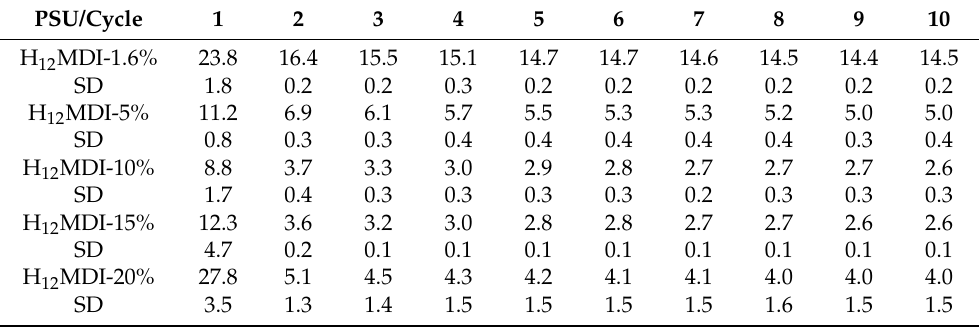
Table A3. Tensile hysteresis at 100% strain of PDMS-based polyurea elastomers synthesized from isophorone diisocyanate (IPDI) with HS contents between 1.4% and 20%. Values are given as an average of three repeated measurements. SD: standard deviation.